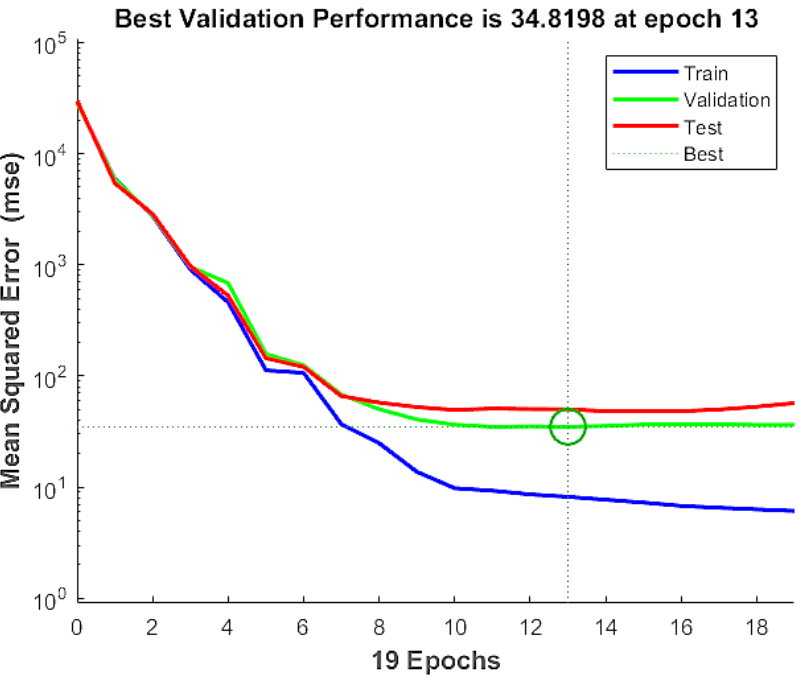
Figure 11. New neural network structure with activation function.